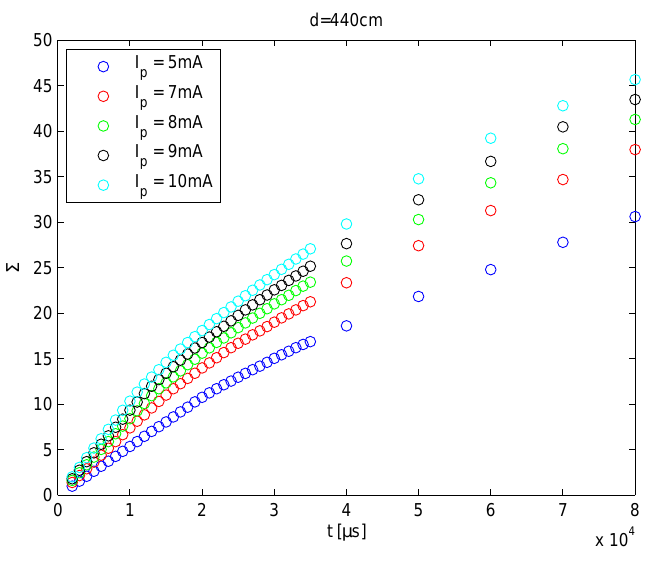
Figure 2. Behavior of (cid:6) with camera exposure time ( t ) obtained for different IRED radiant ) with a distance between the camera and the IRED of 440 cm. intensities ( I p